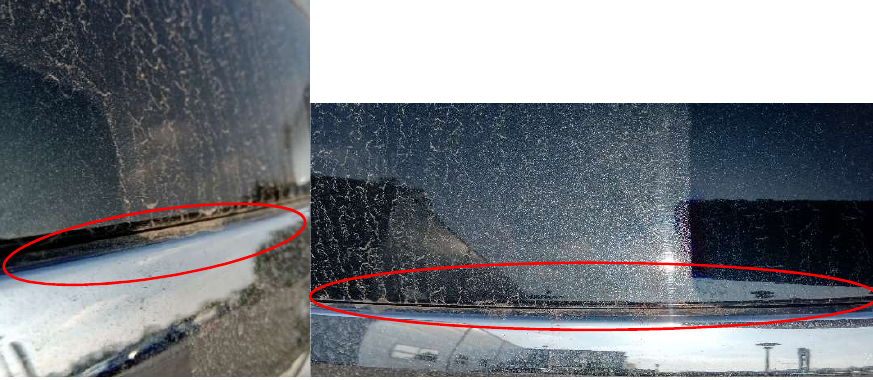
Figure 2. View of the gap between the chrome strip and the vehicle body, through the water entered, causing damage to the boot lid contactor.